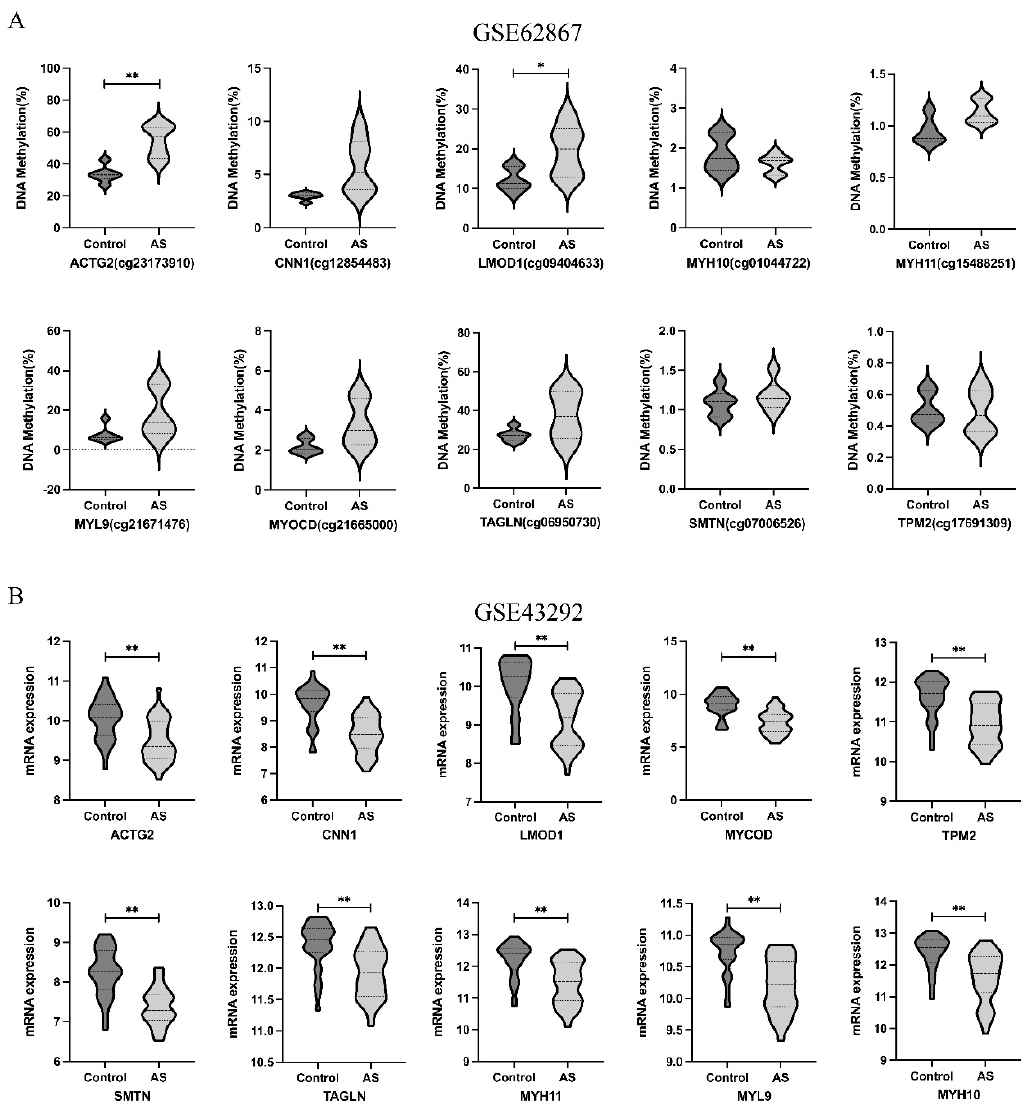
Figure 11. Validation of expression levels and methylation levels of hyper-down genes in AS in gene expression dataset (GSE43292) and DNA methylation dataset (GSE62867). ( A ) The methylation levels of hyper-down genes in GSE62867. ( B ) The expression levels of hyper-down genes in GSE43292. The comparison between the two groups with the paired t-test. GraphPad Prism software was used in statistical analysis. A p -value <0.05 was considered statistically significant. * p < 0.05; ** p < 0.01.